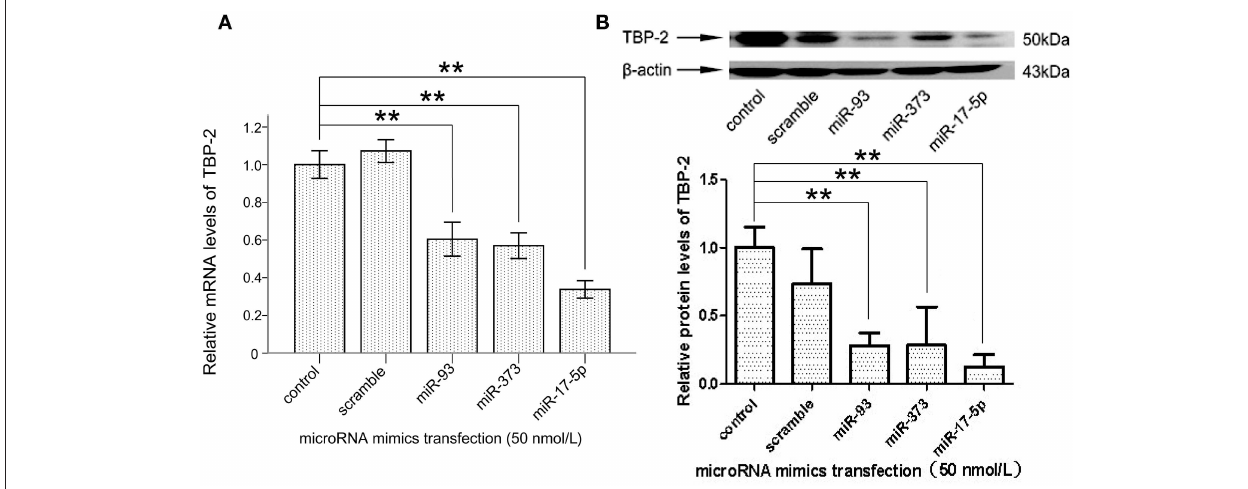
FIGURE 3 | MiR-93, miR-373, and miR-17-5p mimics inhibited the expression of TBP-2 in NCI-H460 cells. (A) The expression mRNA level of TBP-2 in NCI-H460 cells transfected by miR-93, miR-373, and miR-17-5p mimics (** P < 0.01, Bonferroni’s multiple comparisons test). (B) The protein level of TBP-2 in NCI-H460 cells transfected by miR-93, miR-373, and miR-17-5p mimics (** P < 0.01, Bonferroni’s multiple comparisons test).